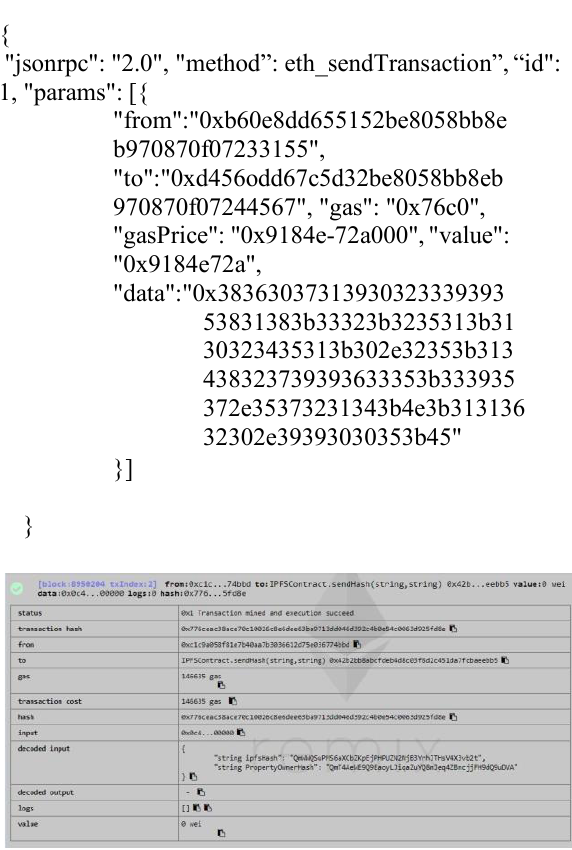
Fig. 4.2 Transaction log after storing the IPFS and